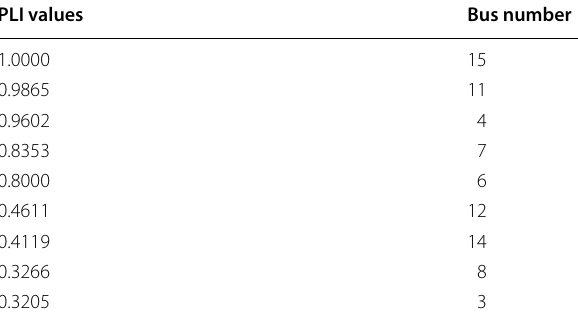
Table 3 PLI values for first ten elements of 69-bus system PLI